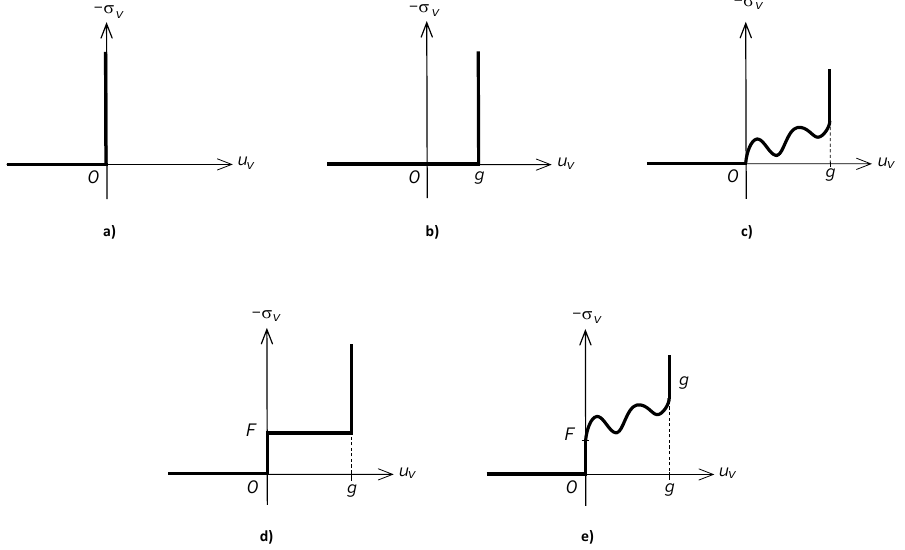
Figure 2. Five contact conditions with unilateral constraints: ( a ) condition (1); ( b ) condition (2); ( c ) condition (7); ( d ) condition (9); ( e ) condition